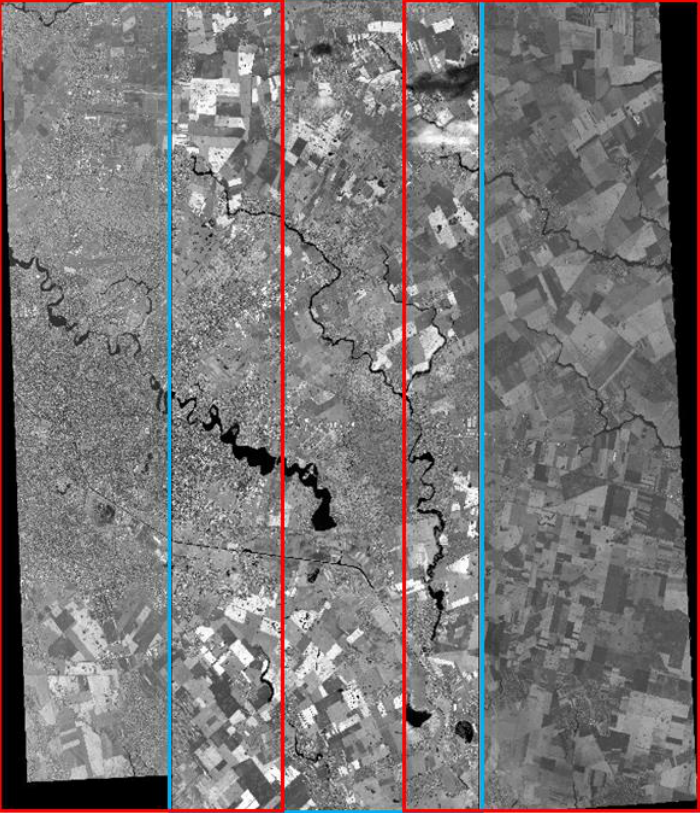
Figure 7. Projected images onto the reference image space.